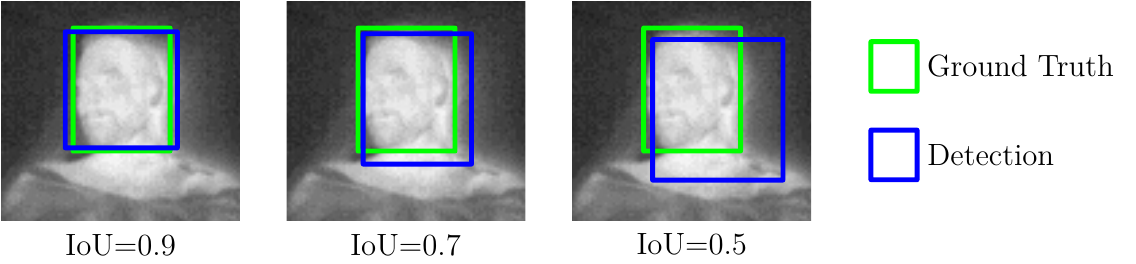
Figure 6. Intersection over Union as an evaluation metric for object